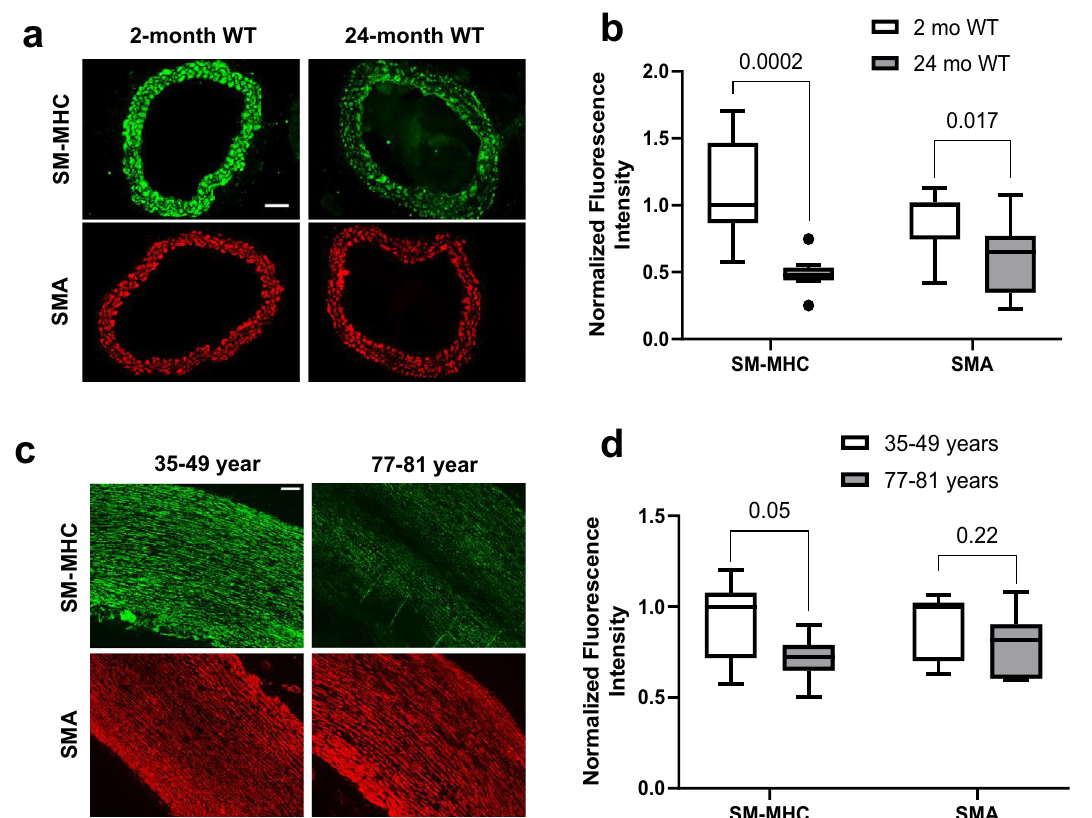
Figure 6. Decreased smooth muscle myosin heavy chain in aged mouse and human arteries. ( a ) Representative images of 2-month (n = 7) and 24-month (n = 9–10) WT mice carotid artery cross sections immunostained for SM-MHC and SMA; scale bar = 50 µm. ( b ) Quantification of carotid artery immunostaining with results plotted relative to the WT controls. ( c ) Representative images of human ascending aorta and aortic root cross sections of young (35–49 years, n = 6–7) and old (77–81 years, n = 7) immunostained for SM-MHC and SMA; scale bar = 200 µm. ( d ) Quantification of immunostaining of ascending aorta and aortic root sections with results plotted relative to the young cohort. Results in b and d show box plots with Tukey whiskers. Significance was determined by 1-tail Mann–Whitney